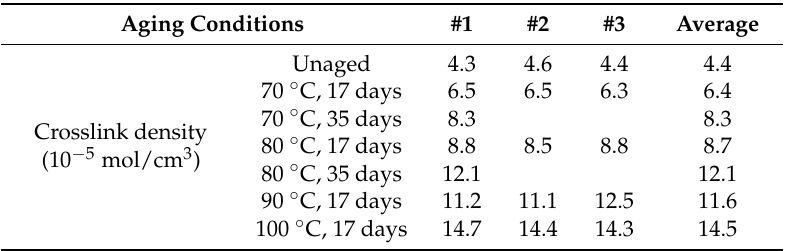
Table 3. Crosslink density (CLD) value according to the aging